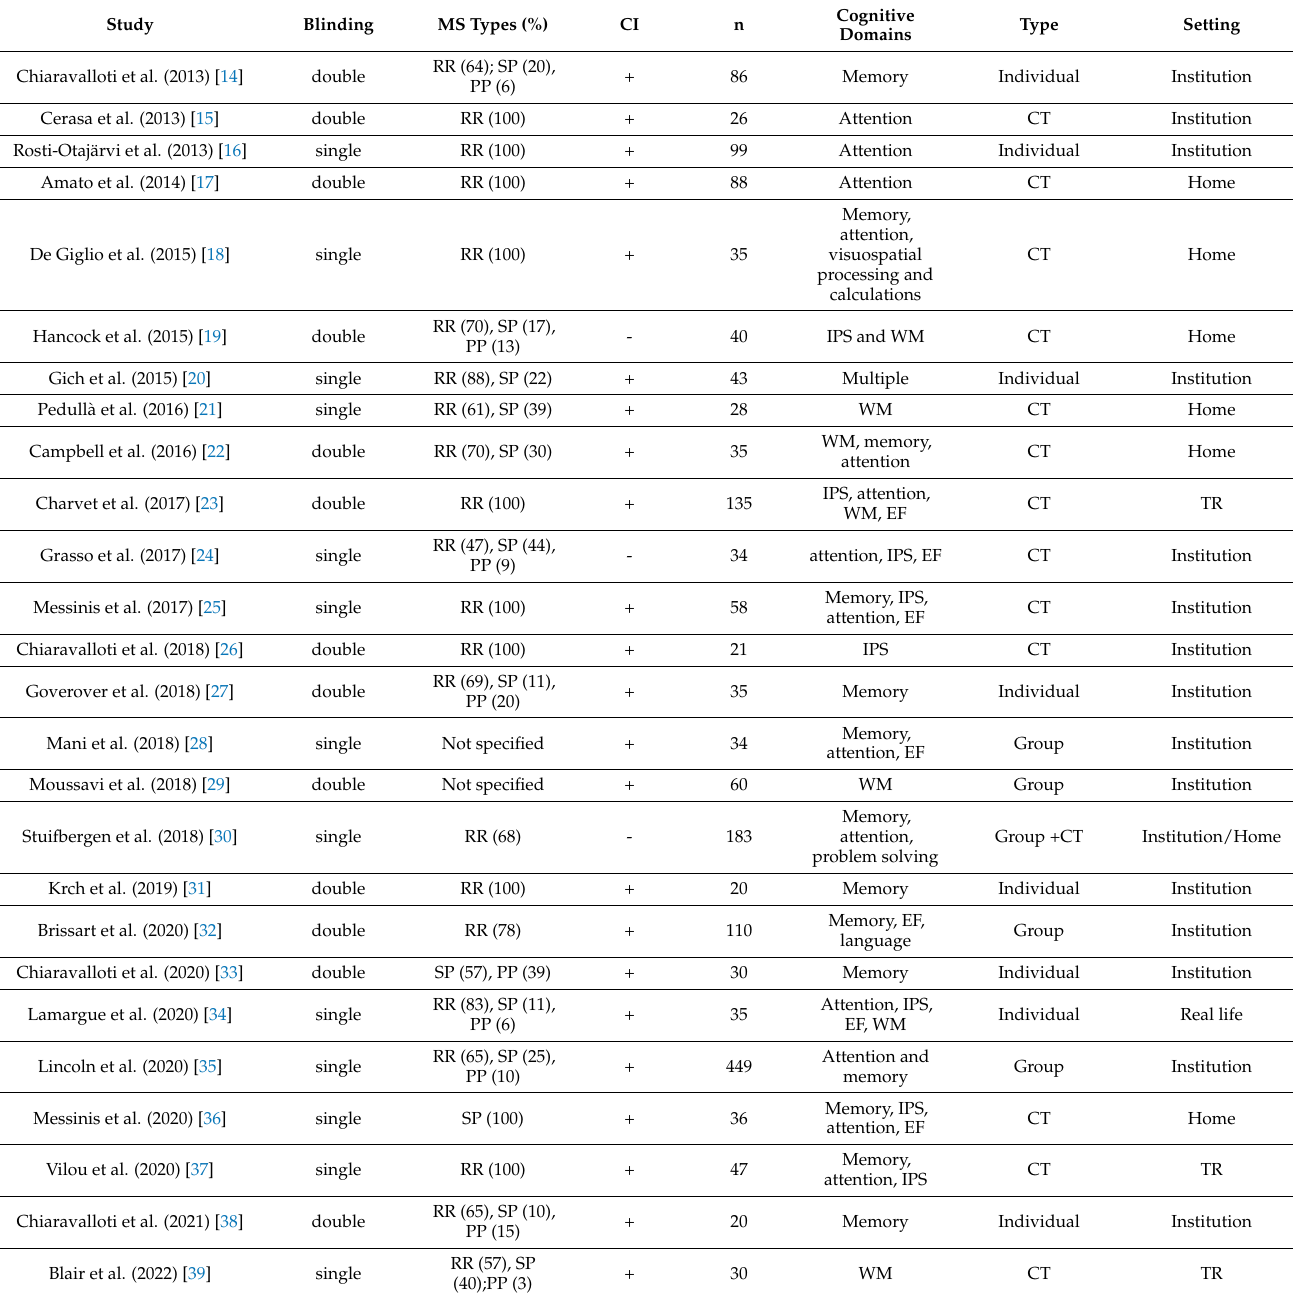
Table 1. Selected